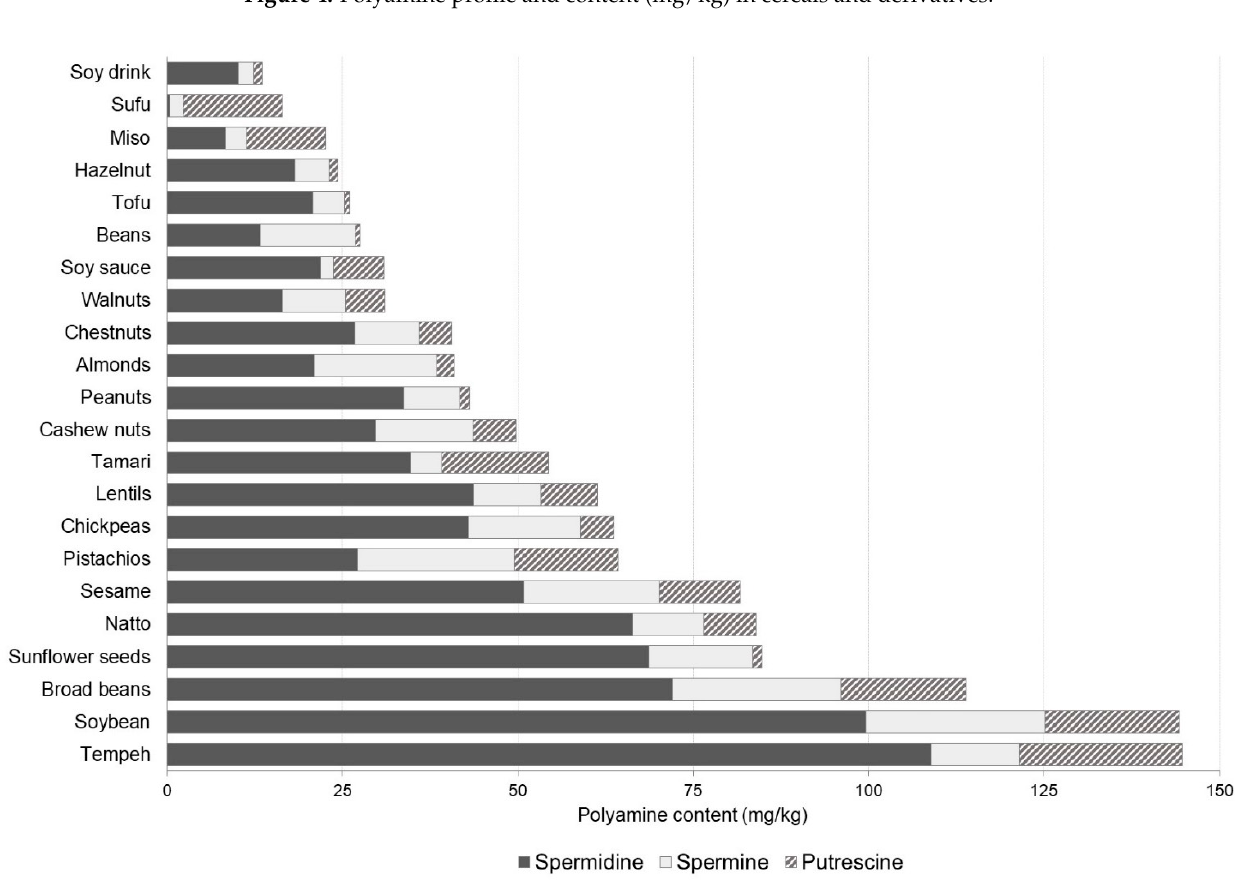
Figure 4. Polyamine profile and content (mg/kg) in cereals and derivatives.